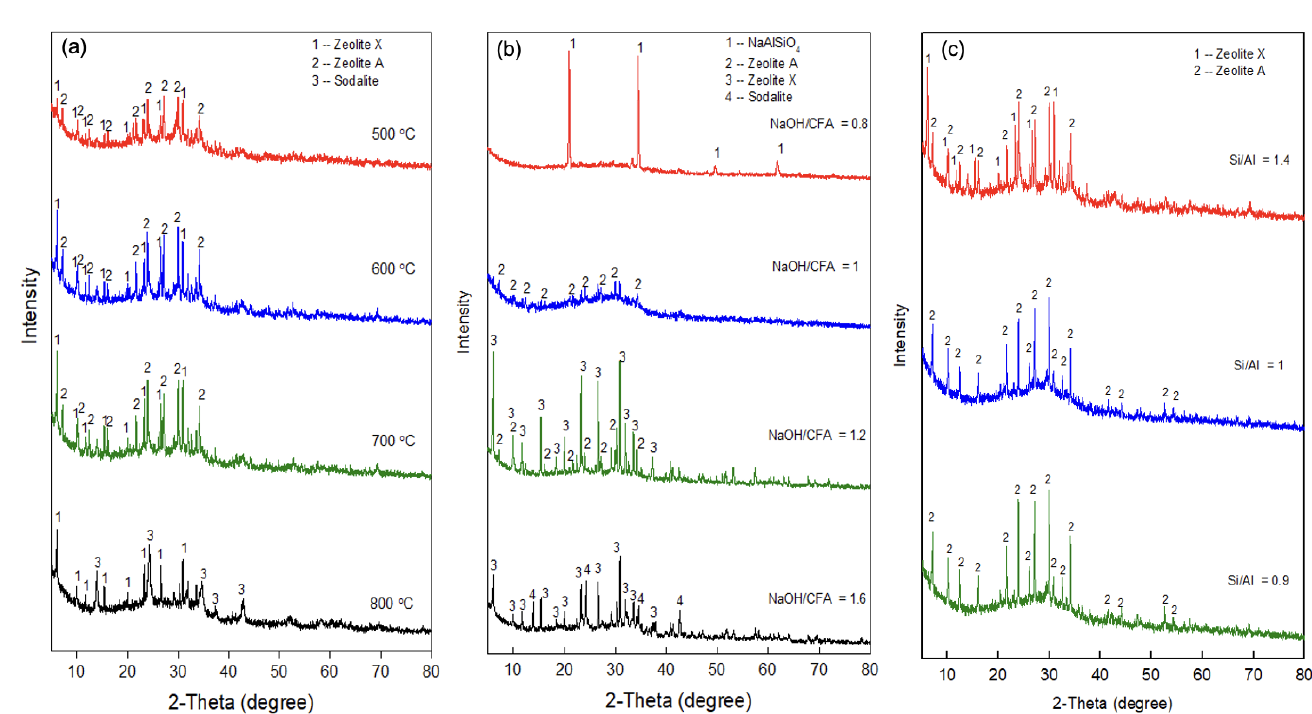
Figure 2. XRD patterns of ASNA synthesized under different roasting temperatures ( a ), ratios of alkali (NaOH) to coal fly ash ( b ), and molar ratios of silicon to aluminum ( c ). As shown in Figure 2b, when the ratio of alkali to coal fly ash was 0.8, the main com- ponent of the obtained product was sodium aluminum silicate. This may be because when the amount of alkali is low, the quartz and mullite crystal phase in the coal fly ash is de- stroyed to form sodium silicate aluminate, but its activity is relatively weak, and an ASNA cannot be formed during the crystallization process [35].